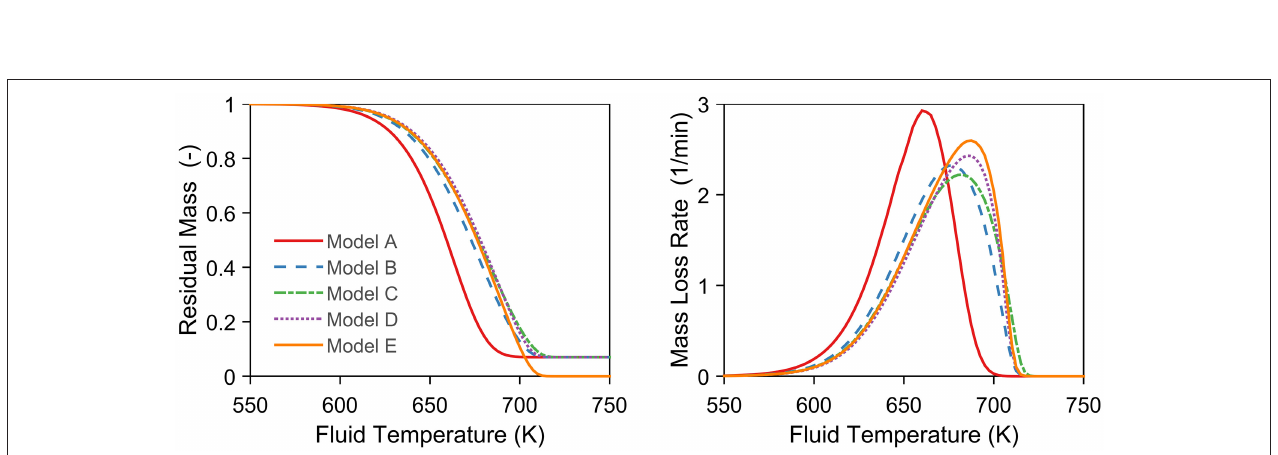
FIGURE 4 | Sensitivity study of the model formulation of the thermal model. The simulations represent a 5mg cellulose sample in inert atmosphere at 150 K/min. Model E has not been corrected with the final residual mass in this case.